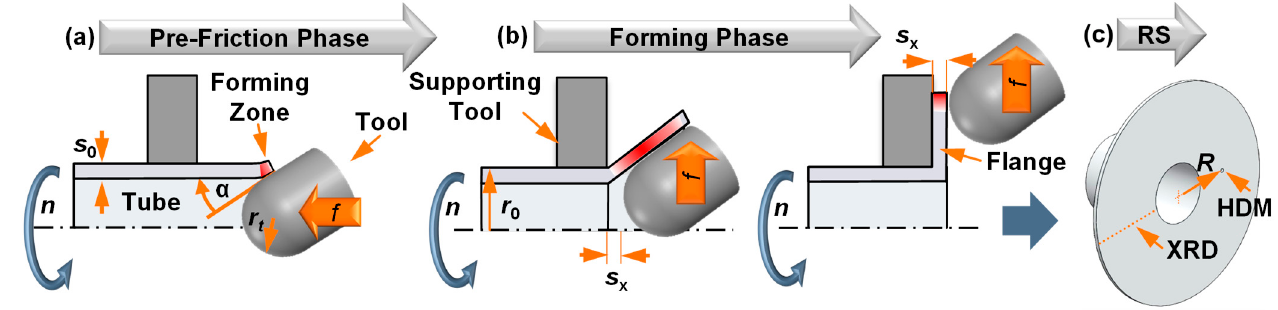
Figure 1. Flange forming through the friction spinning of tubes [4]. ( a ) Pre-friction phase ( b ) Forming phase ( c ) Residual-stress measurement.